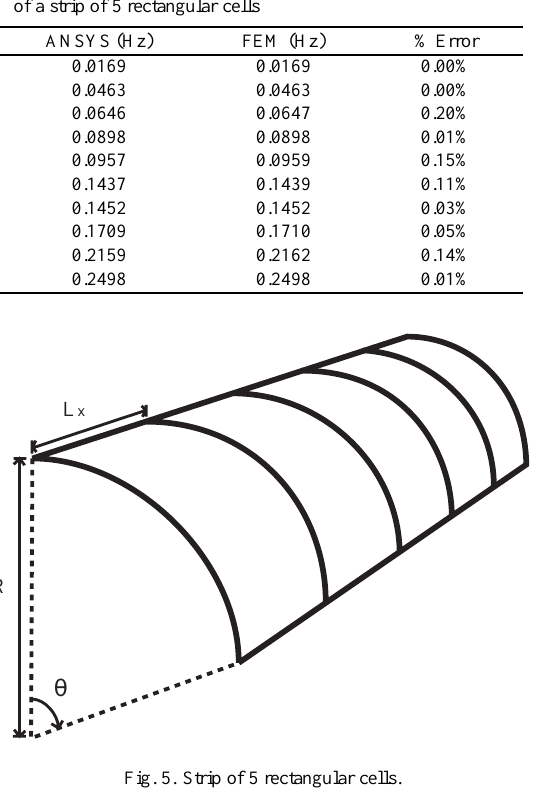
Table 4 ANSYS vs FE predictions for the first 10 natural frequencies